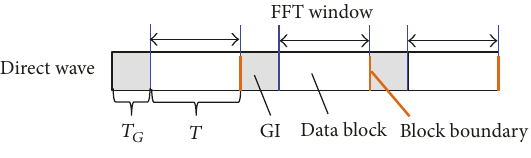
Figure 2: OFDM frame structure and timing positions for FFT windowing.